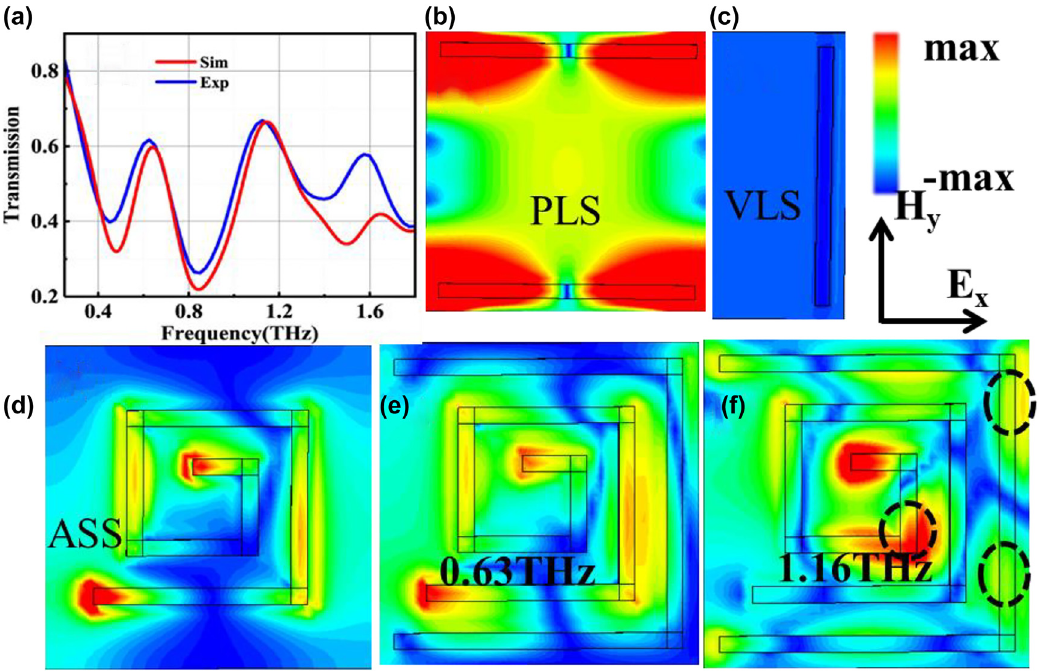
Figure2: Simulatedelectricfieldintensitydistributionof themetasurfaces: (a)experimental (blueline)andsimulated(red line)transmission spectra of the PGPP@MS biosensor sample. (b) – (d) Simulated electric fi eld intensity distributions at 0.63 THz of the PLS (b), VLS (c), and ASS (d) arrays. (e) Simulated electric fi eld intensity distribution of the EIT mode at 0.63 THz. (f) Simulated electric fi eld intensity distribution of